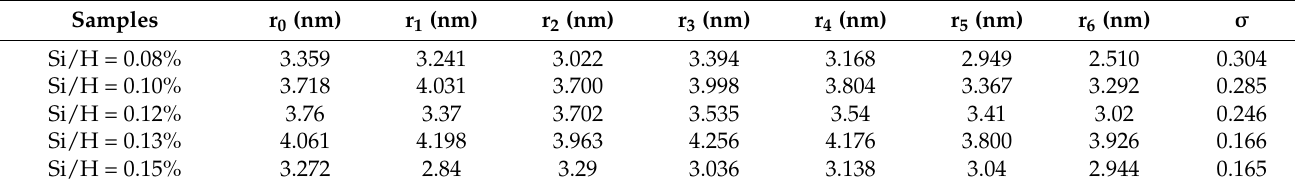
Figure 10. Locations of surface roughness measurements for 6-inch wafers. Table 1. RMS measurement results of 6-inch 4H-SiC wafers as a function of Si/H